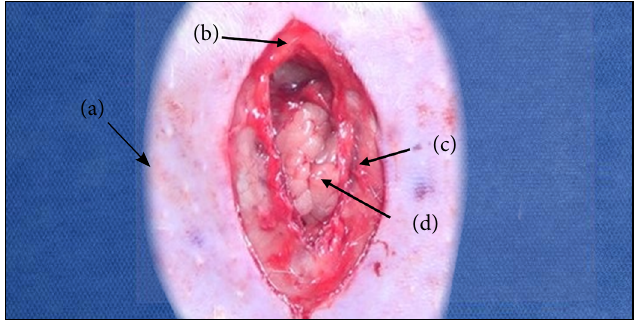
Figure 1 - Median incision of 4 cm in the skin and longitudinal incision of the linea alba and peritoneum for an extension of 3 cm. The structures observed from the most superficial to the most profound are: (a) Skin; (b) Subcutaneous cell tissue; (c) Aponeurosis; (d) Abdominal cavity.